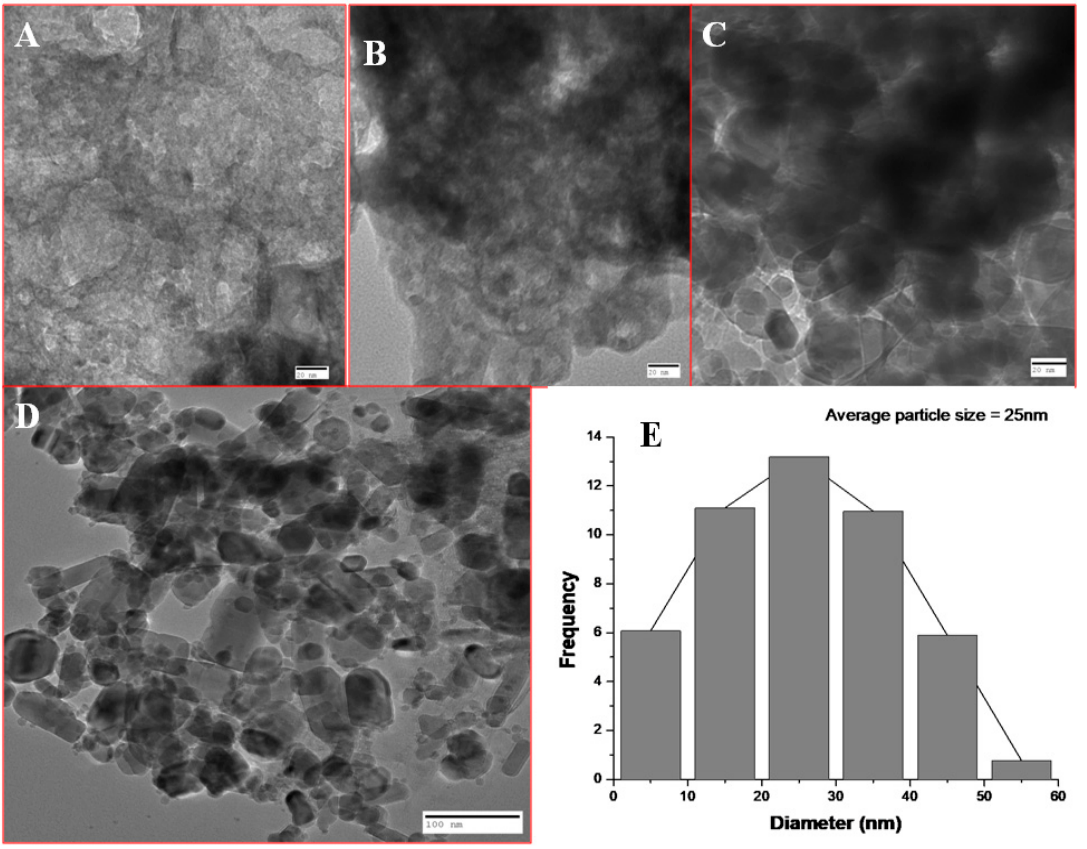
Figure 5. TEM of BM-ZnO NPs at different concentration of extract. ( A ) 10 mL extract, ( B ) 20 mL